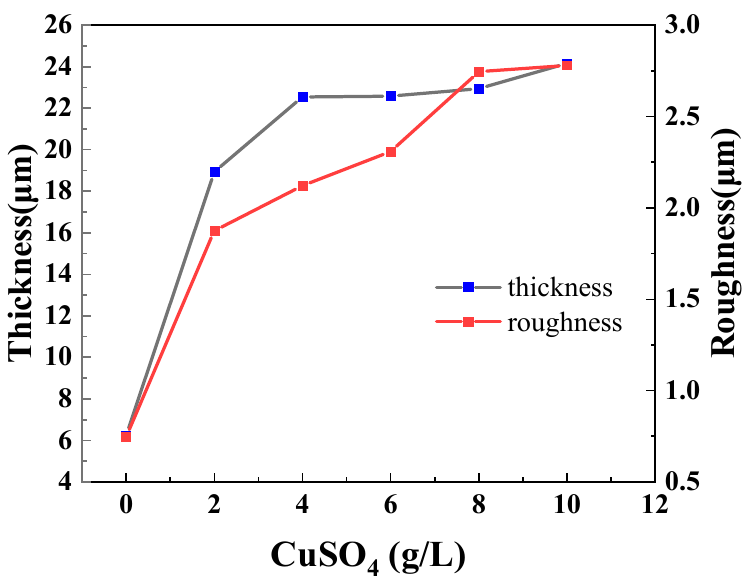
Figure 2. Thickness and roughness of MAO coating with different concentrations of CuSO 4 .